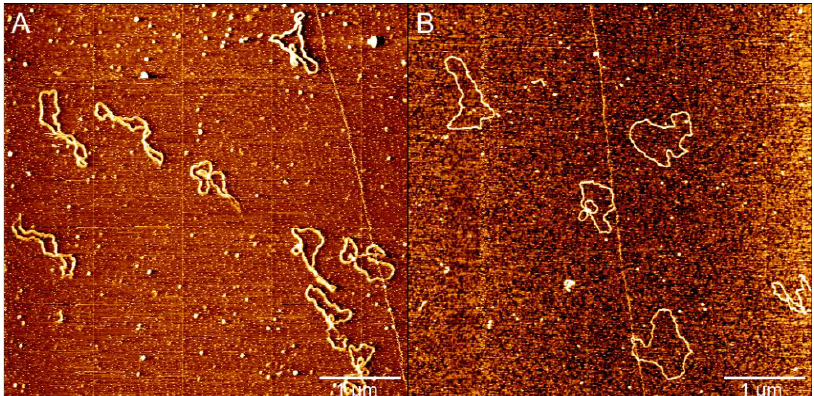
Figure 1. ( A ) AFM images of pBR322 plasmids in deposition buffer (25 mM KCl, 10 mM MgCl 2 , 10 mM HEPES (pH 7.5)). ( B ) AFM images of pBR322 plasmids in deposition buffer (1 mM MgCl 2 , 10 mM HEPES (pH 7.5)) by syringe pump, and the flow rate is 2 min/mL.